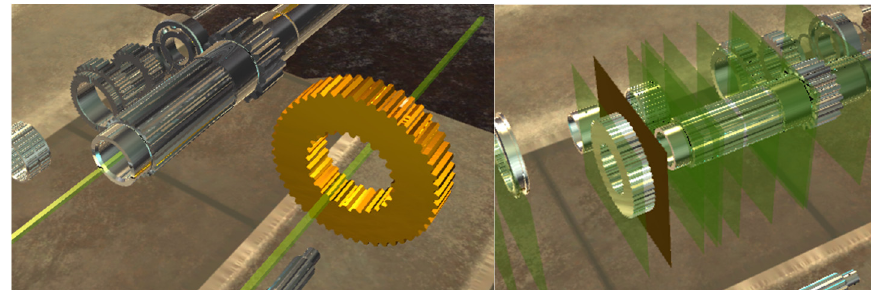
Figure 15. Assembly datum axis and face.